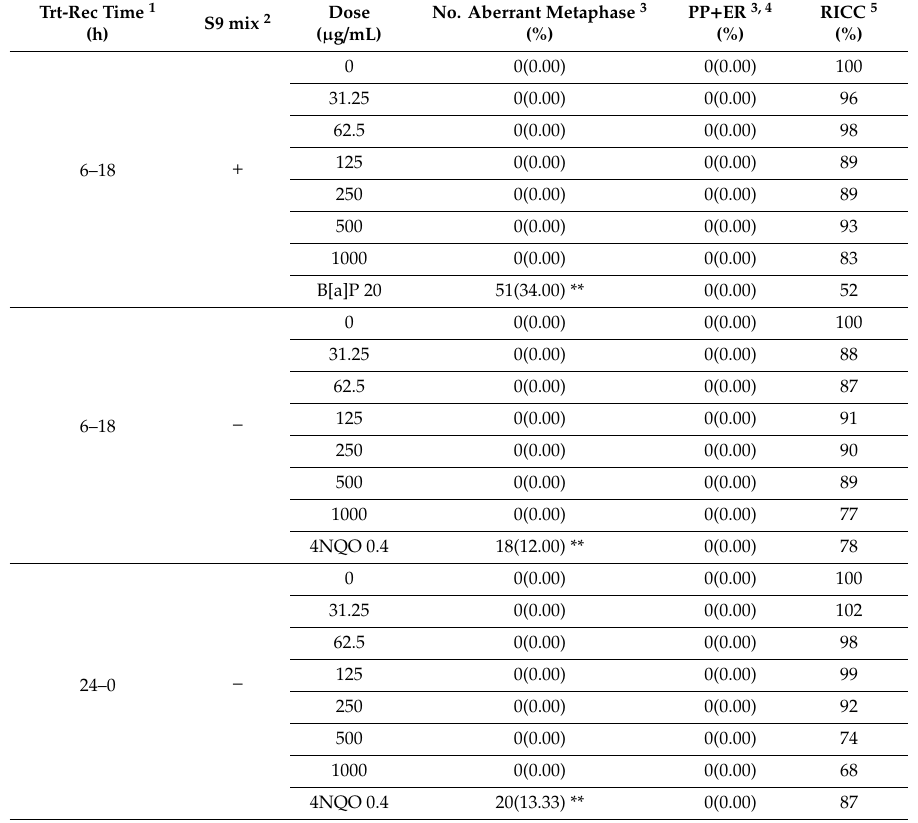
Table 3. In vitro chromosomal aberration assay in Chinese hamster lung cells treated with BLE0. Trt-Rec Time 1